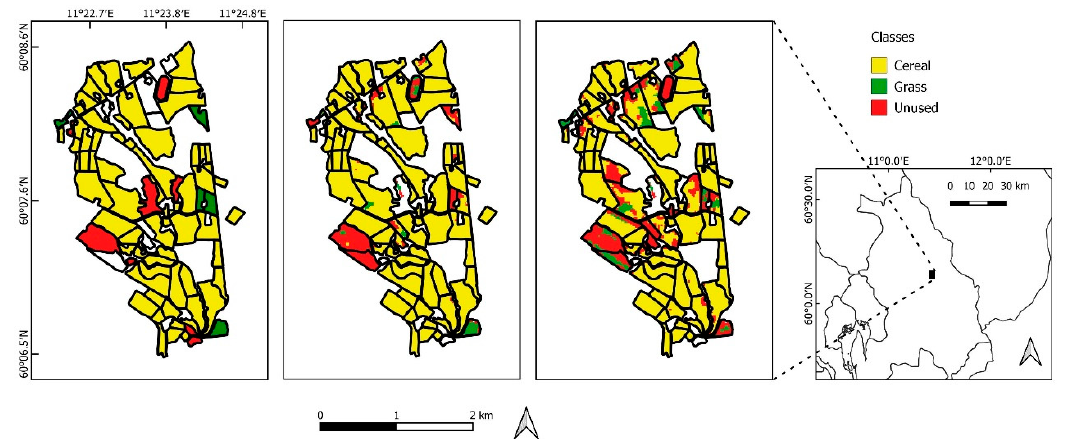
Figure 5. Comparison of the land use types as registered in the Norwegian Agricultural Environmental Monitoring Program